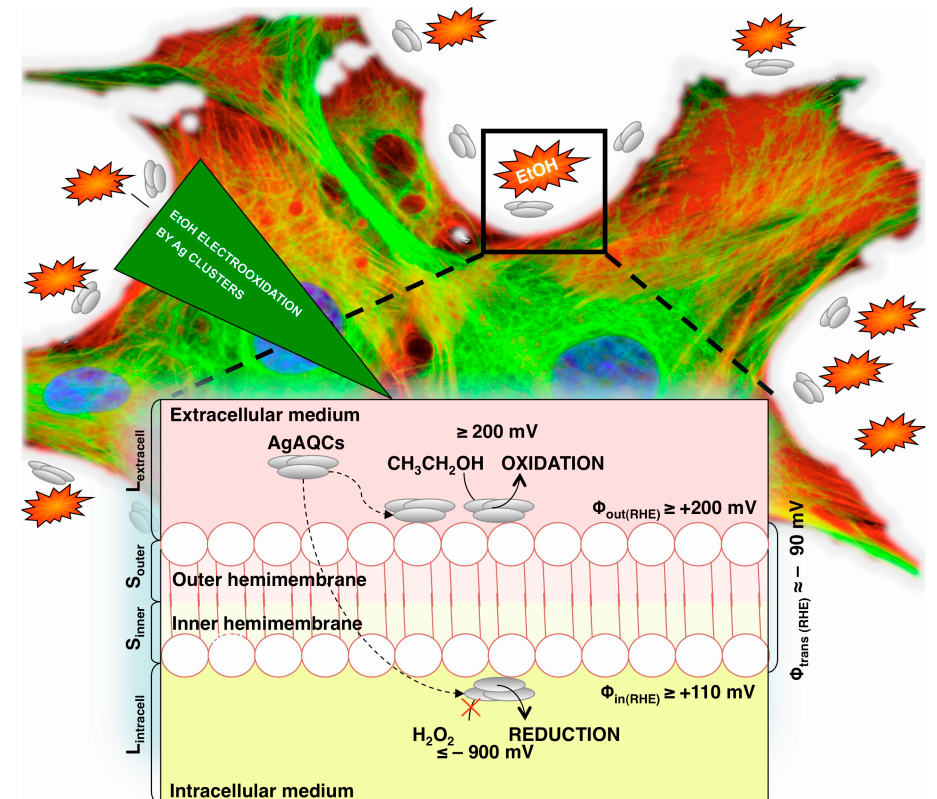
Figure 9. The scheme of the cytoprotective action of AgACQ against Ethanol in mammalian cells. The image was obtained from